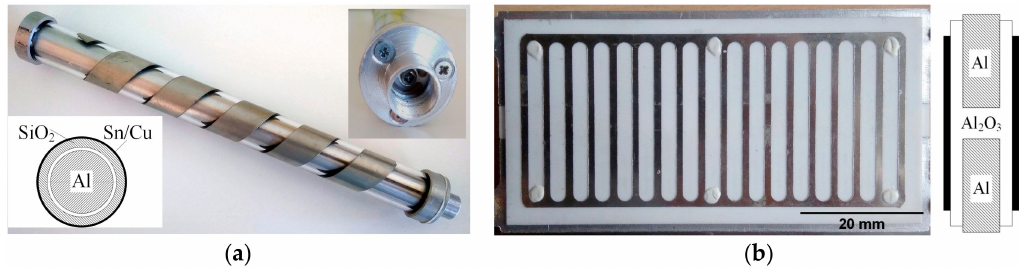
Figure 4. DBD OGs: ( a ) volume flow-through arrangement of a spiral-tubular design, ( b )